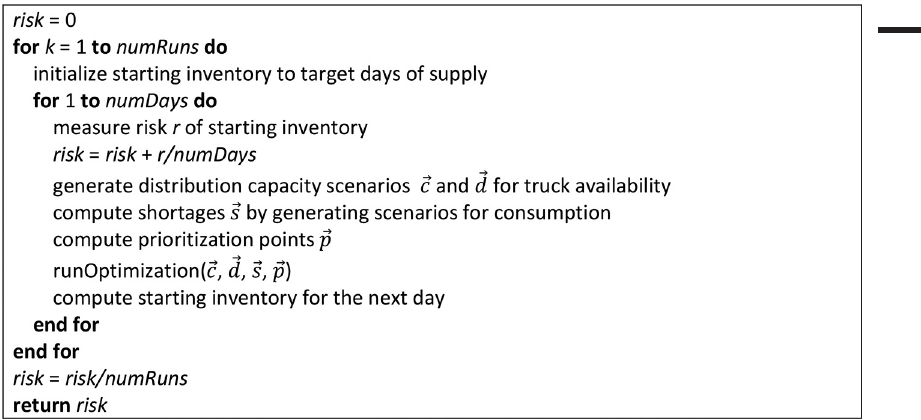
Algorithm 1 . This function computes risk of supply shortages, for a given fl eet of trucks. The call to the runOptimization function solves an instance of our integer programming model (1)-(7) for each day in the speci fi ed time horizon. Risk is